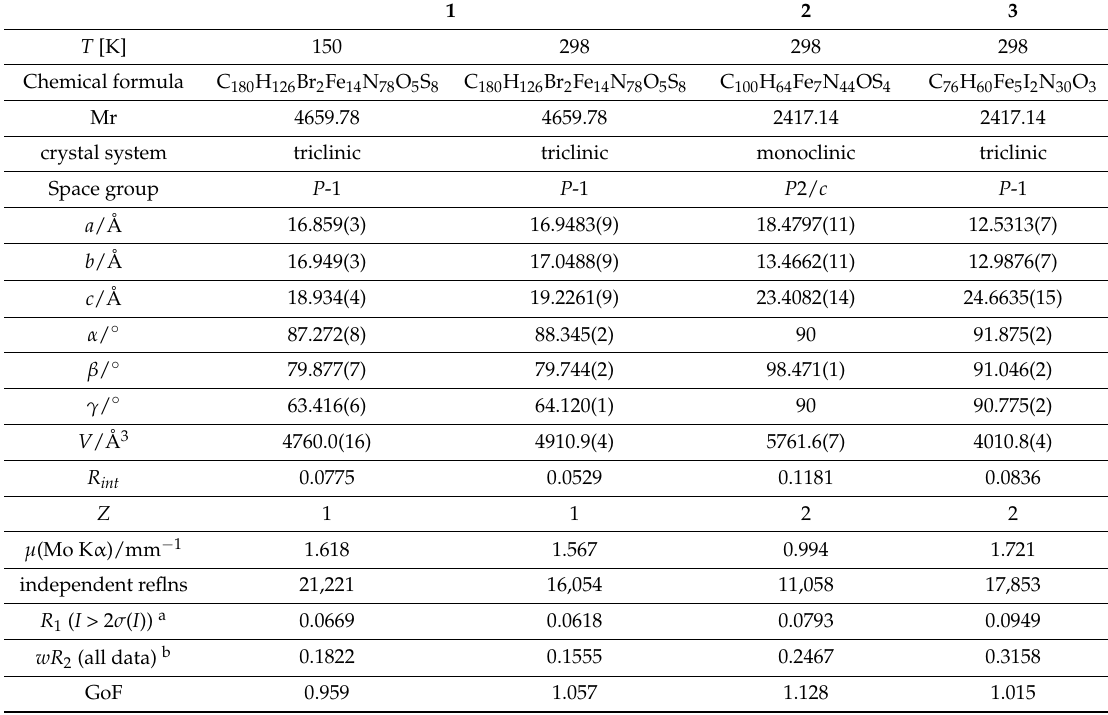
Table 1. Summary of the Crystal Data and Structure Refinement Parameters for 1 , 2, and 3